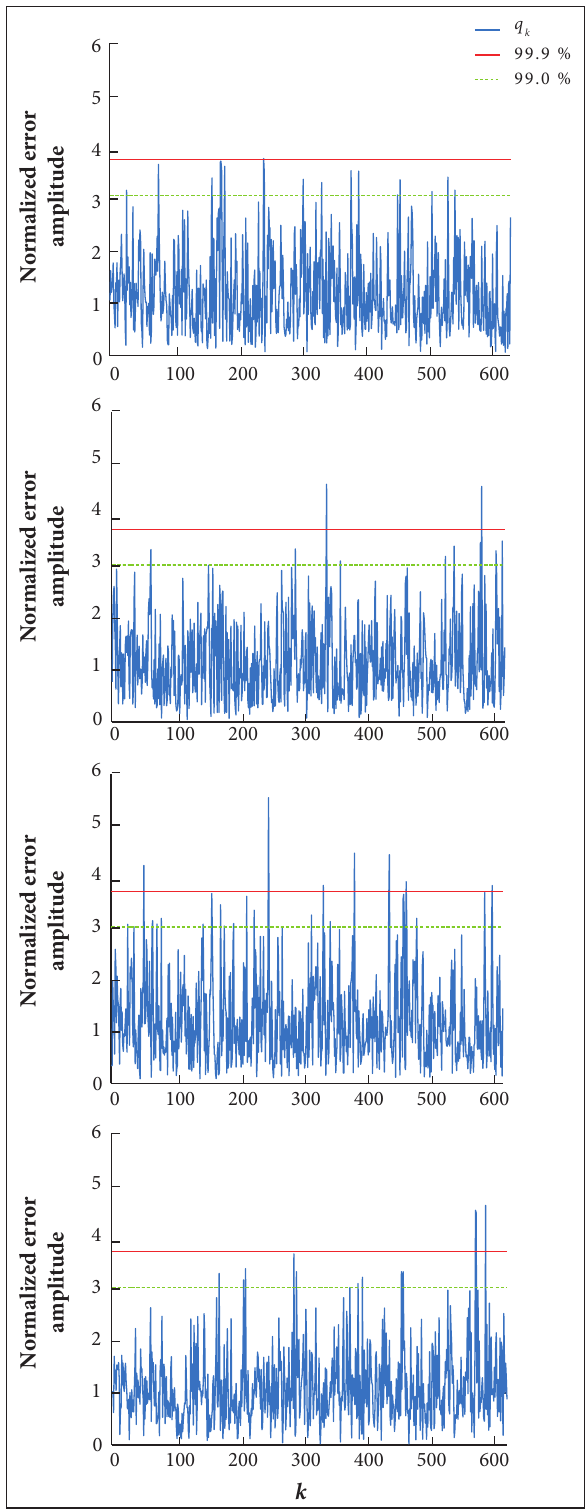
Performance Comparison of the IMMPDAF Algorithm Using Real and Simulated Radar Measurements